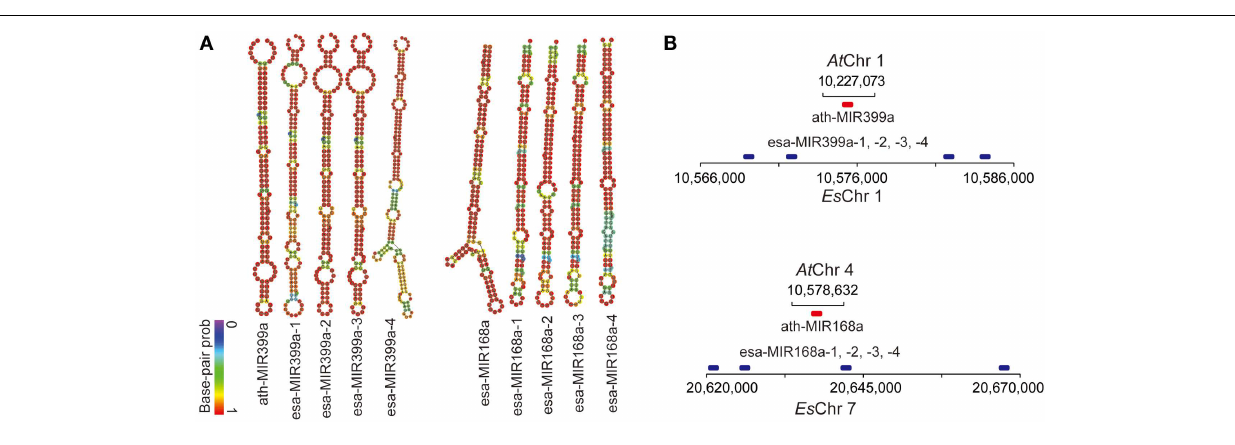
the At CDPK family. (C) The genes involved in “ubiquitin-dependent protein modification” are more enriched in E. salsugineum than in A. thaliana .